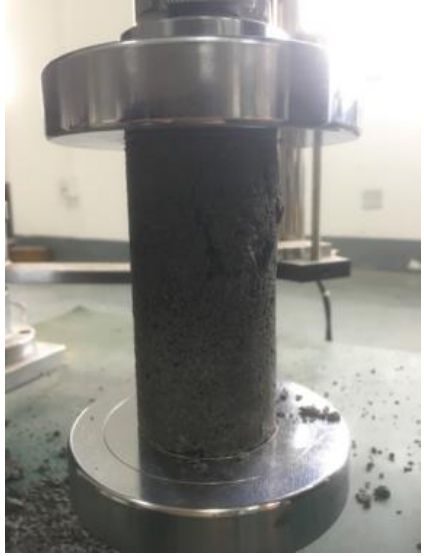
Figure 5. Fragmentation diagram of simulated coal sample.